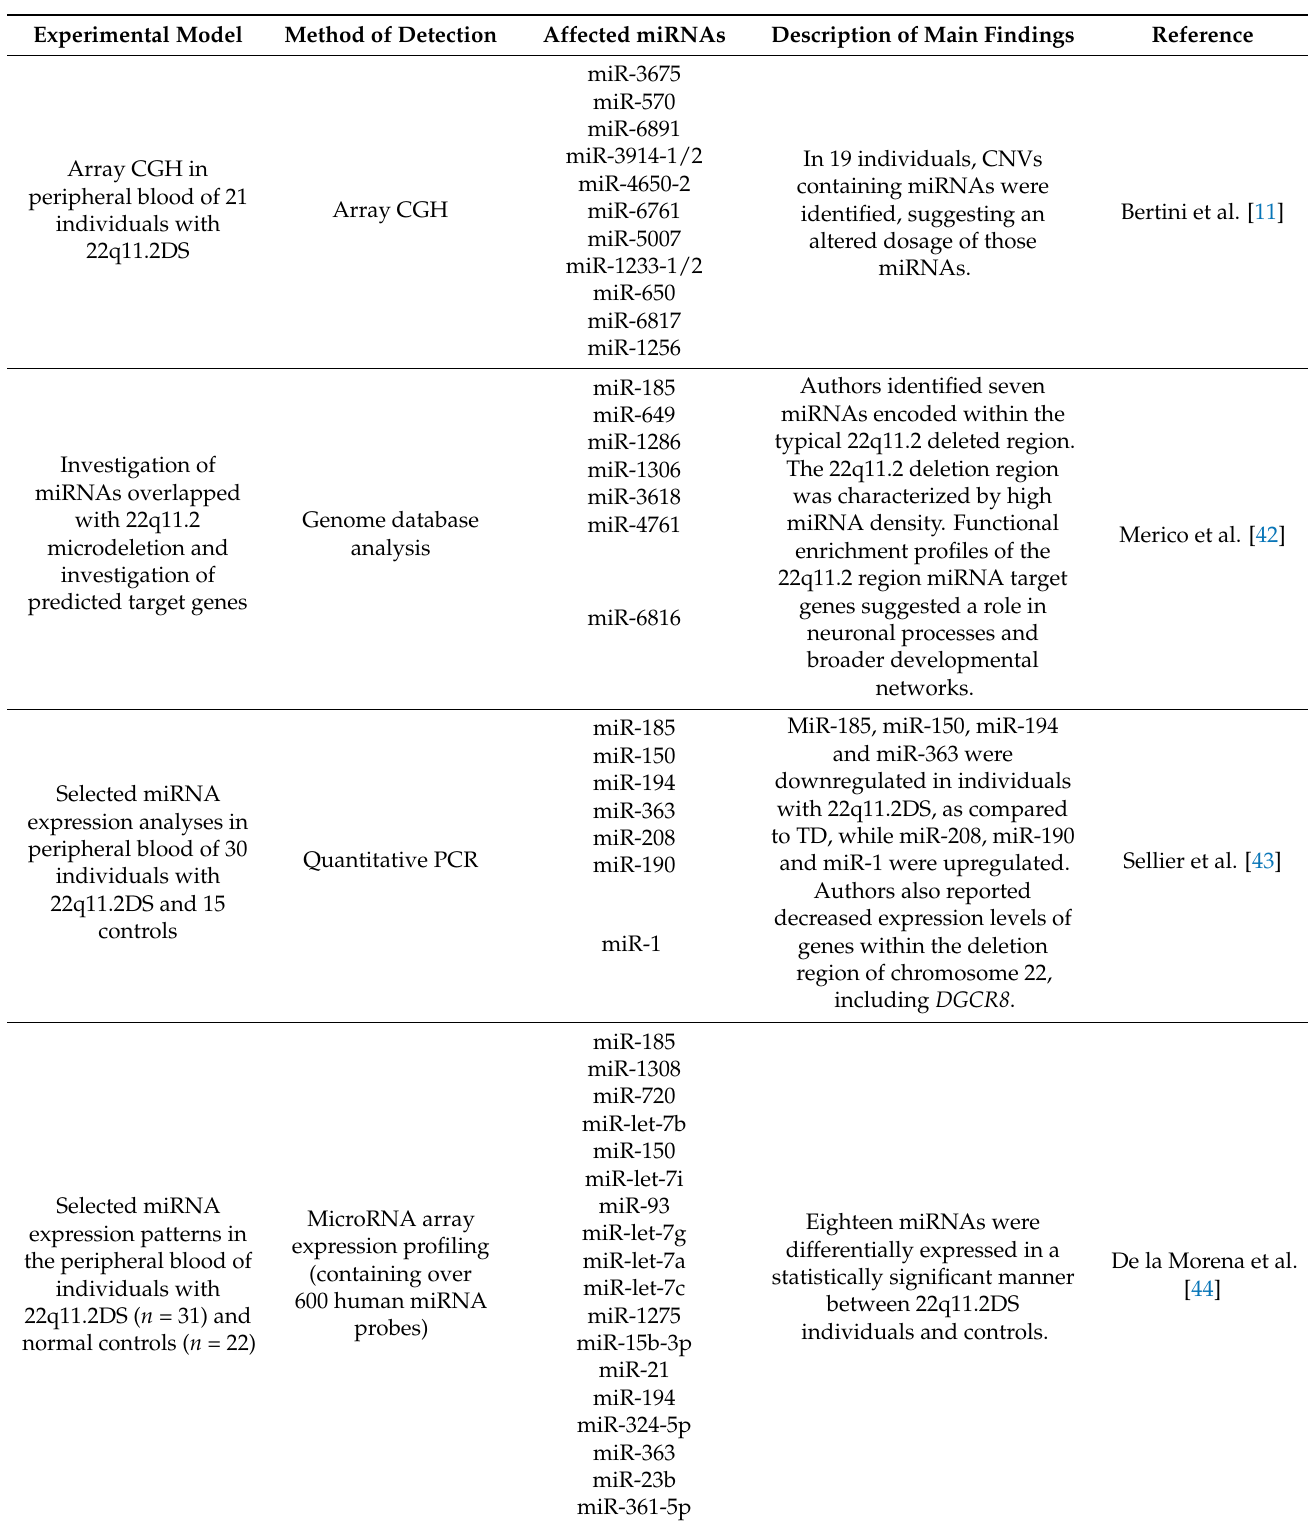
Table 2. Selected papers about 22q11.2 deletion syndrome and alteration of